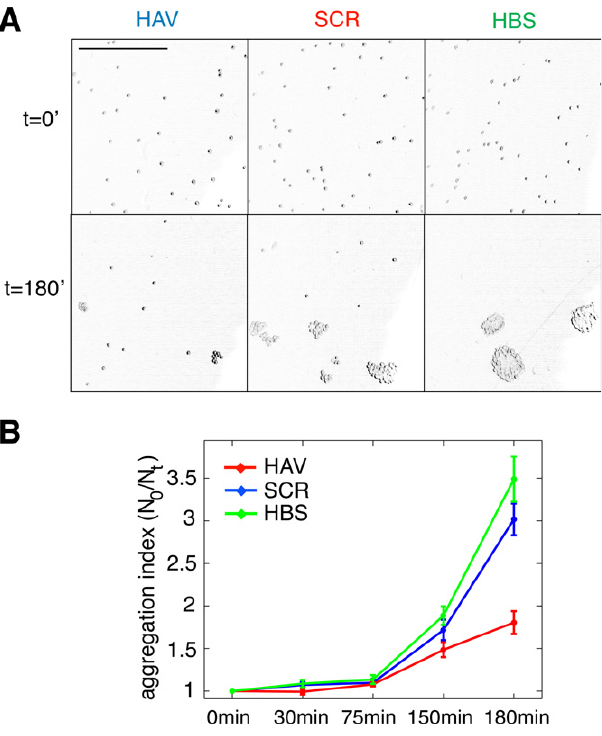
Figure 1. Ten-minute AHAVD (but not AADHV) peptide treatment dis- rupts N-cadherin mediated adhesion. (A) Differential interference con- trast images of L cells plated onto slides at different time-points, after being treated with HAV, SCR, or HBS for 10 minutes (see Materials and methods section). Scalebar = 650 μ m. (B) Plot of the aggregation effi ciency of L